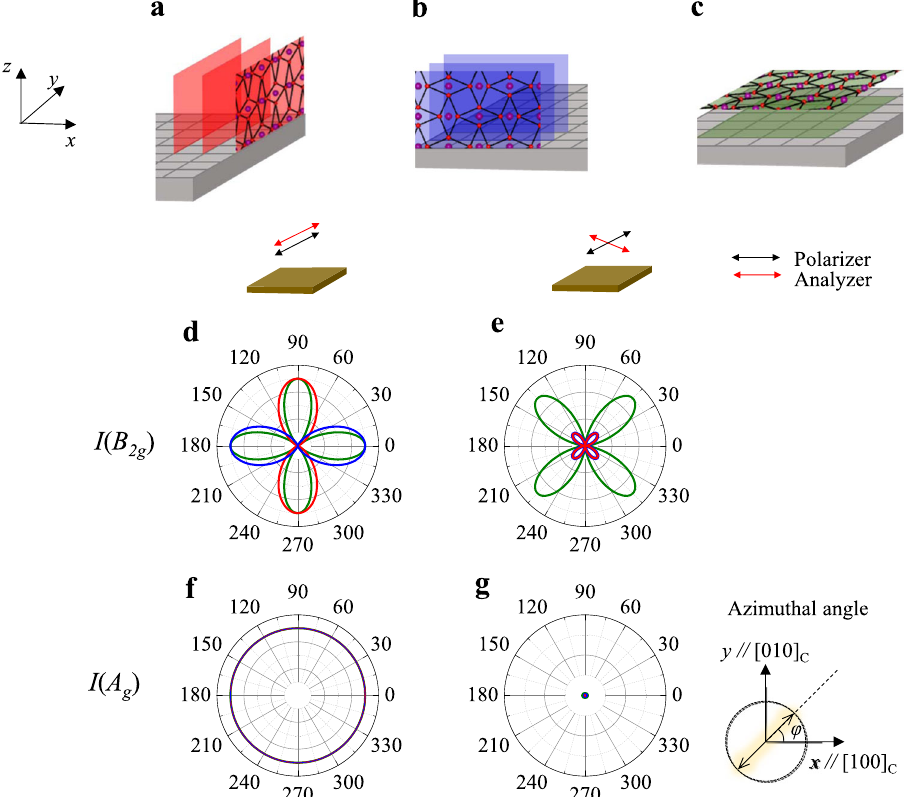
Fig. 2 Theoretical analysis of the Raman intensities. Schematic diagrams describing the possible orientations of JT planes parallel to substrate (100) C ( a ), (010) C ( b ), and (001) C ( c ). Polar plots of the B 2g modes in parallel ( d ) and cross ( e ) polarization con fi gurations. Polar plots of the A g modes in parallel ( f ) and cross ( g ) polarization con fi